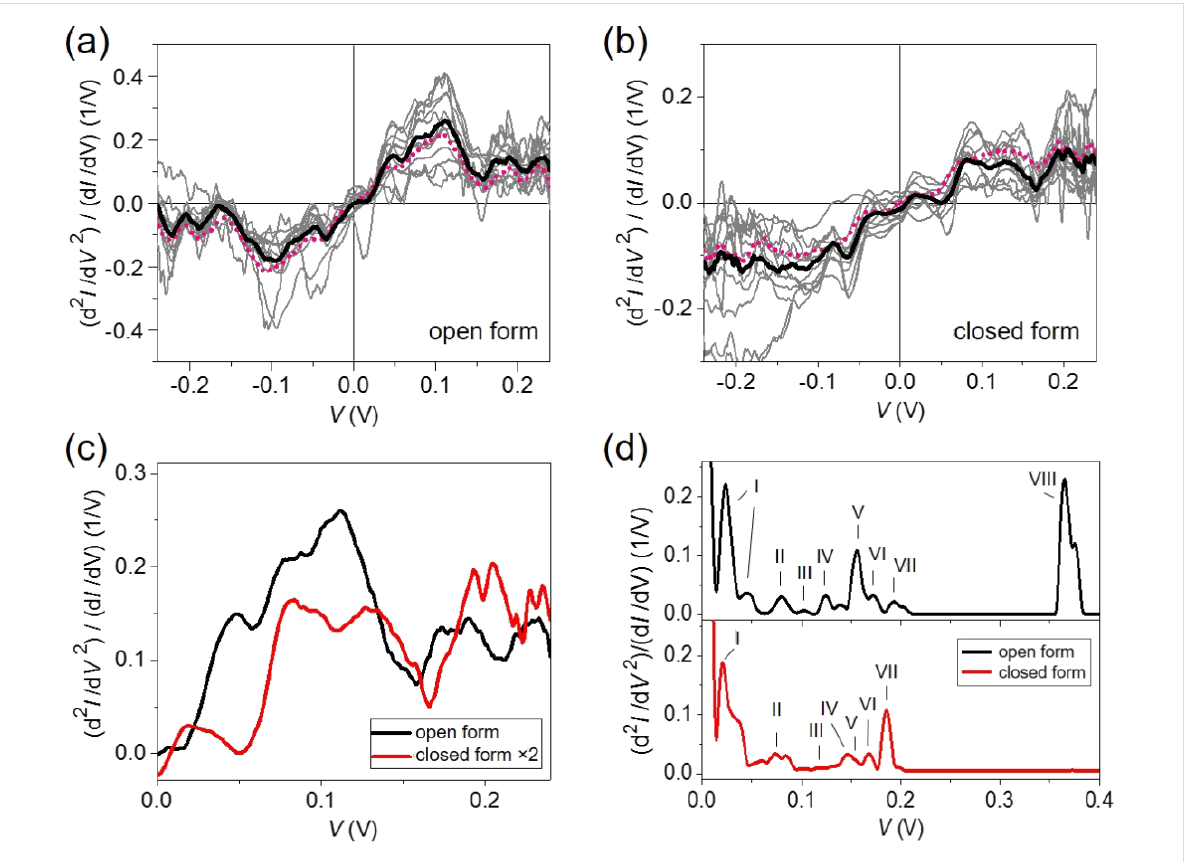
Figure 3: Experimentally measured IET spectra (gray) are displayed for (a) the open and (b) the closed form. For each form twelve curves were aver- aged (solid black line) and the average was symmetrized (pink-dotted line), using the function y = [ f ( x ) − f ( − x )]/2. (c) Averaged and symmetrized IET spectra for the open (black) and the closed (red) form, displayed only in the positive bias range. The IET spectrum of the closed form is magnified by a factor of 2. (d) Theoretically computed IET spectra for the open (upper panel, black) and closed (lower panel, red) form. Each mode, indicated with Roman numerals, is listed in Table